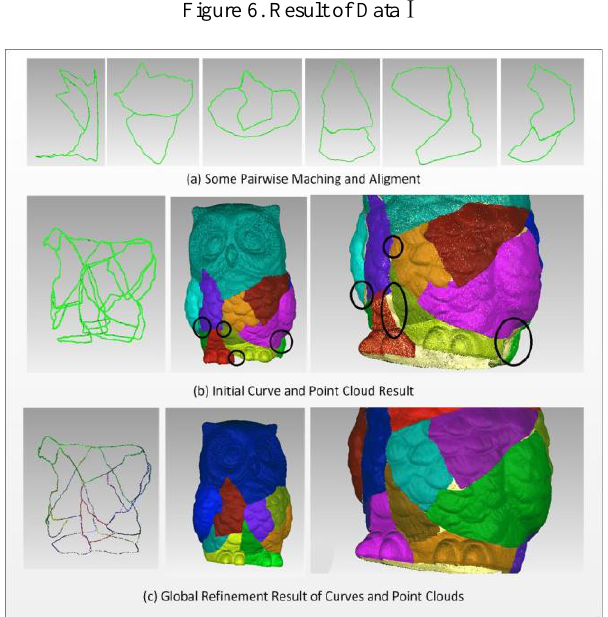
Figure 6. Result of Data Ⅰ